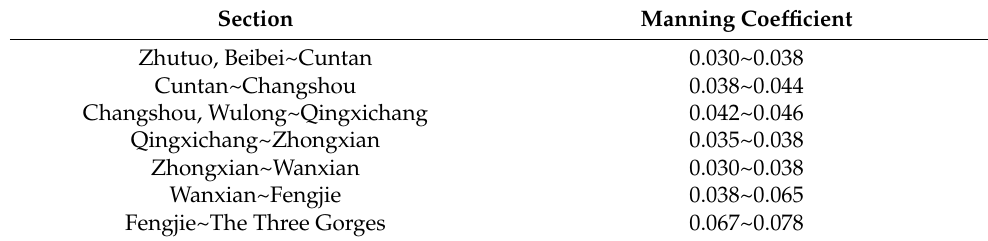
Table 2. The Manning coefficient of the river.